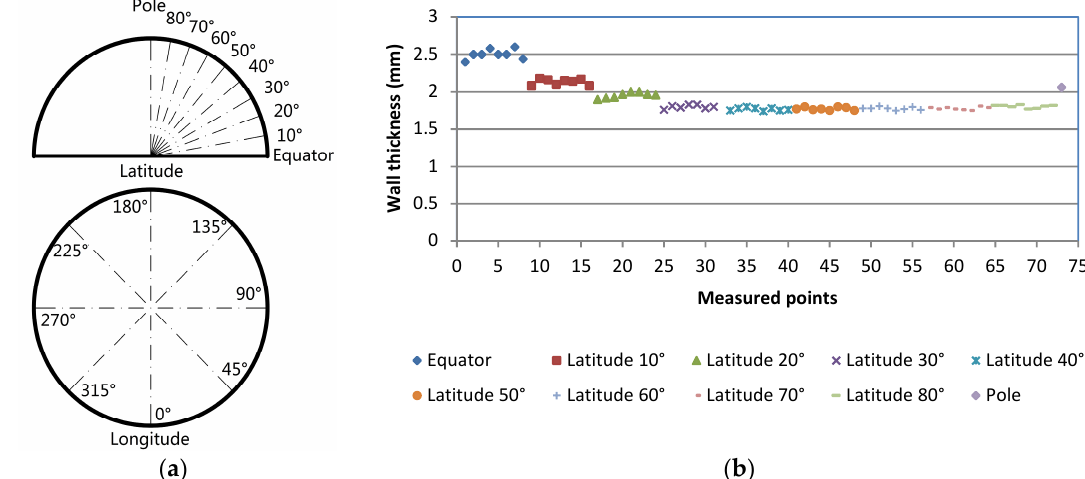
Figure 6. Wall thickness measurement results of a sintered and machined hemispherical housing. ( a ) Schematic diagram of wall thickness measured points of the hemispherical housing. ( b ) Measurement results. Table 2. Diameter, weight-to-displacement ratio, and collapse strength of the Si 3 N 4 floatation spheres.